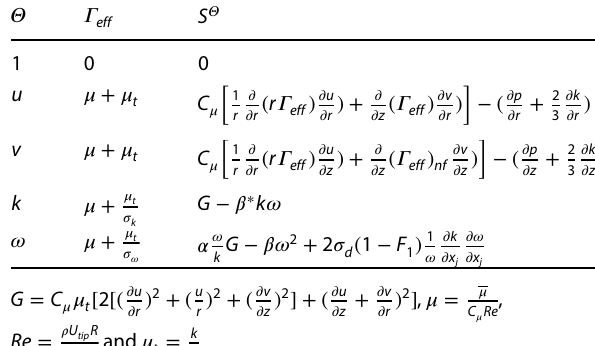
Fig. 1 Solution domain for mathematical model